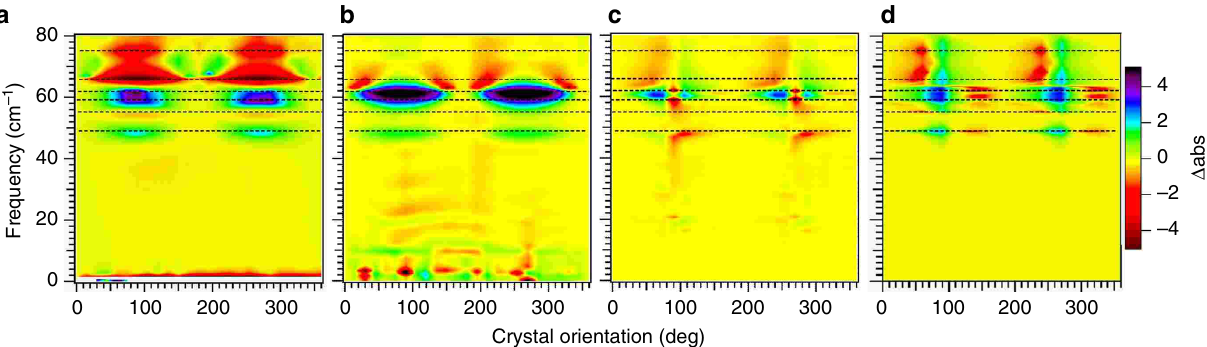
Fig. 3 Relationship of PV-ATM data to vibrational absorbance for sucrose. The measured Δ abs( ν , θ ) using ( a ) far- fi eld orientation dependent absorption, b near fi eld anisotropic absorbance (ATM), and c PV-ATM. The THz radiation polarized in the a - b plane and the 0° orientation corresponds to the THz polarization parallel to the a axis. Also shown is simulation of the PV-ATM measurement ( d ). The simulations indicate that the increased structure in the PV-ATM spectra compared to anisotropic absorption arises from sensitivity to both the resonant anisotropic birefringence and the EO detector crystal polarization